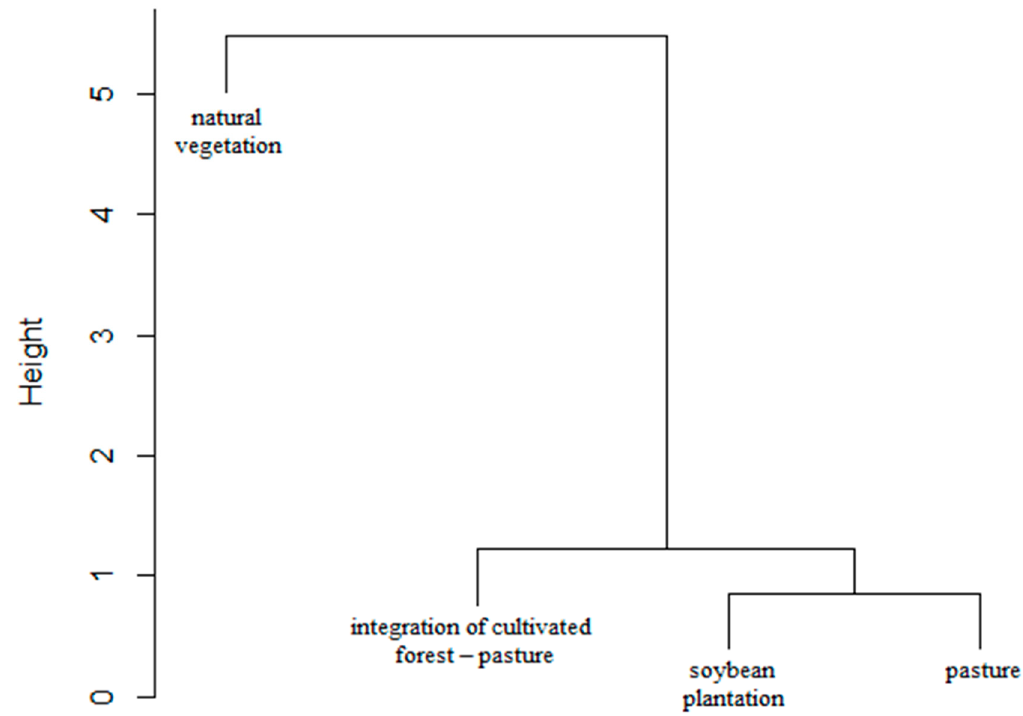
Figure 1. Similarity in mite communities between ecosystems (based on Euclidean distances) taken into account in this study: natural vegetation; soybean cultivation; pasture; integration of cultivated forest–pasture; physicochemical properties of soil, at Sucupira, Tocantins, Brazil.